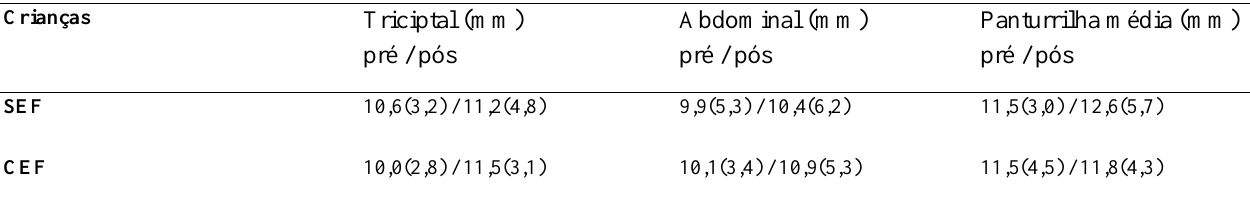
Tabela 2. Média e desvio-padrão das medidas de dobras cutâneas triciptal, abdominal e panturrilha média para as crianças sem aulas de educação física (SEF) e com aulas de educação física (CEF), nos pré- e pós-teste.